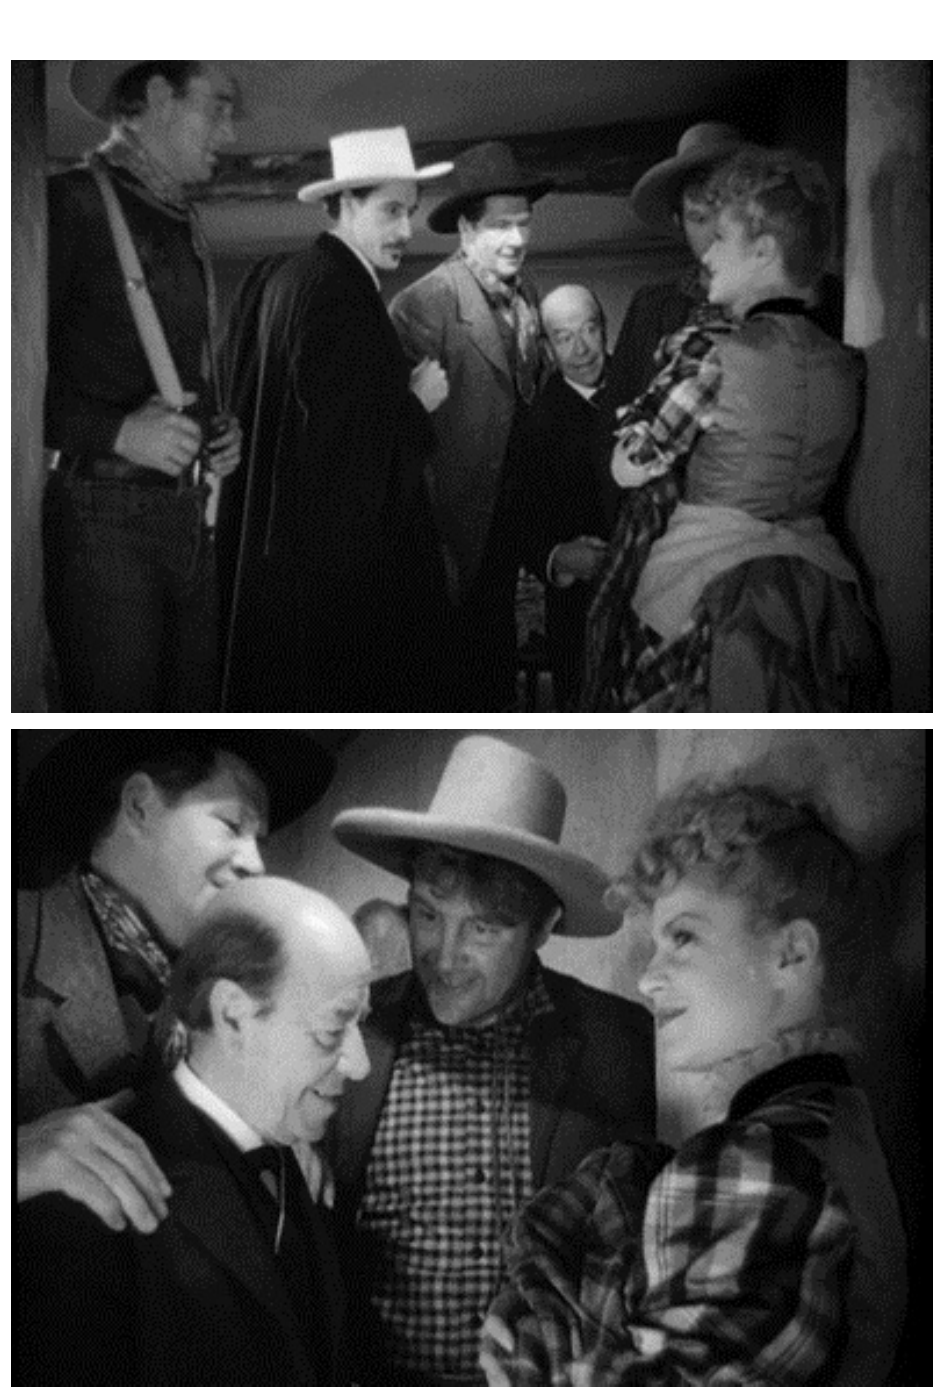
Figure 12: Dallas transformed into the vision of motherhood. Note the second shot in which she glows and catches Ringo’s [out of the frame]